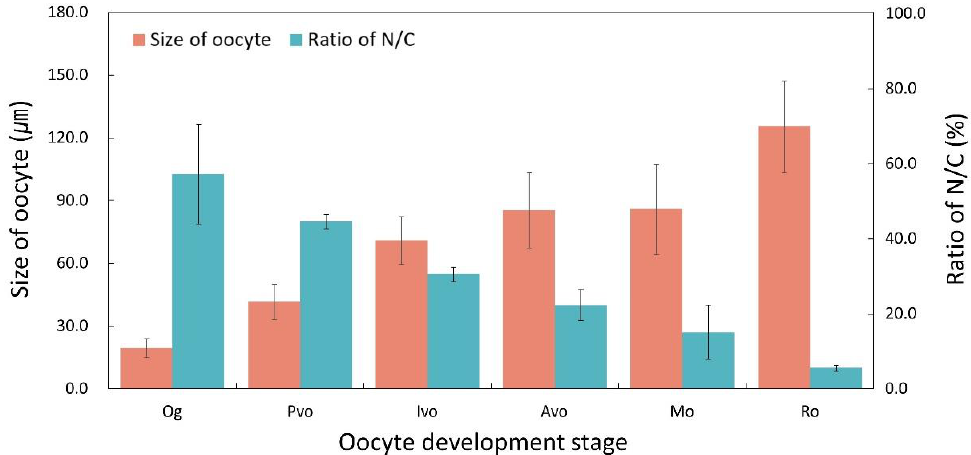
Figure 5. Change of the oocyte size and nucleus ratio to cytoplasm during oogenesis in Buccinum osagawai . Avo: active vitellogenic oocyte; C: cytoplasm; Ivo: initial vitellogenic oocyte; Mo: mature oocyte; N: nucleus; Og: oogonium; Pvo: previtellogenic oocyte; Ro: ripe oocyte.